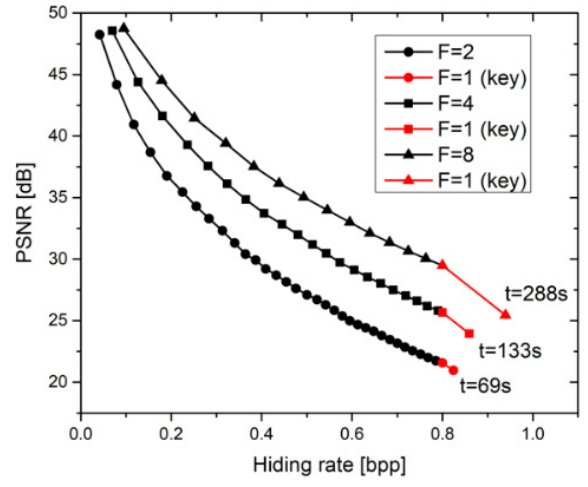
Figure 9. PSNR visual quality according to hiding rate.